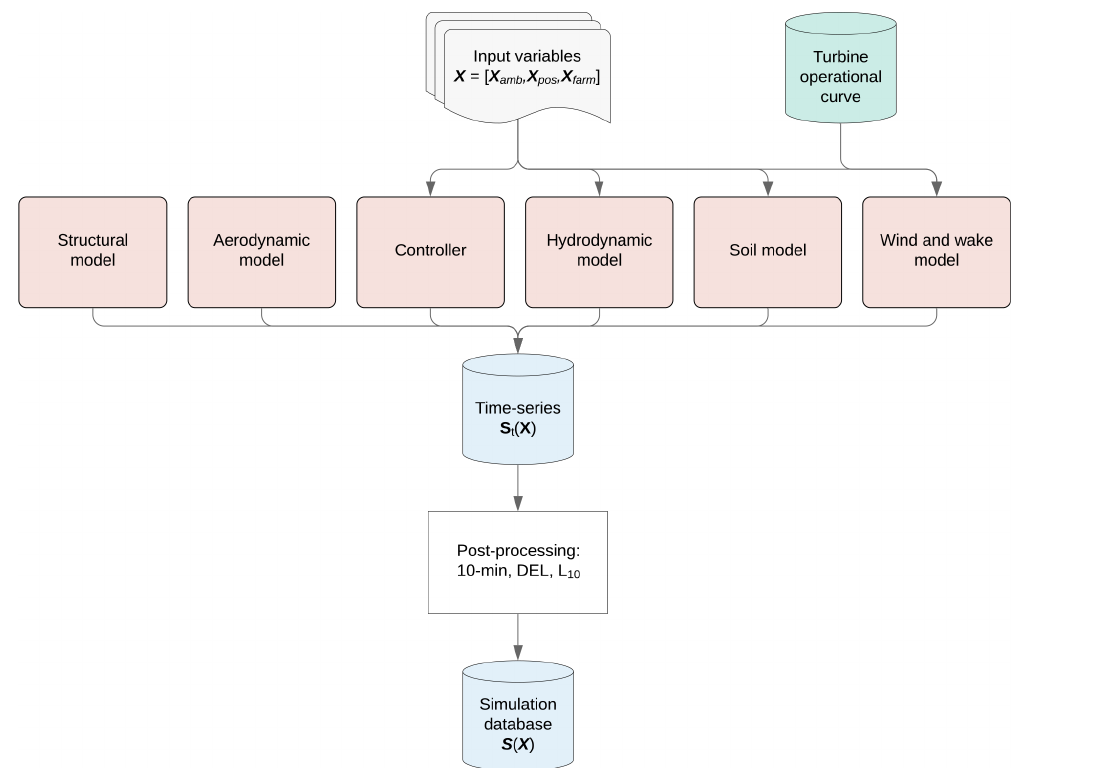
Figure 2. Process of aero-servo-hydro-elastic simulations using sampled input variables.